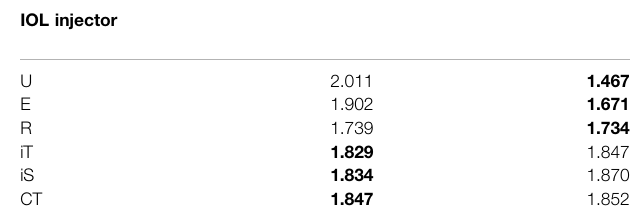
TABLE 1 | Material parameters for healthy porcine corneas at different strain rates (Tonsomboon et al., 2014). Strain rate ( mm · min − 1 )